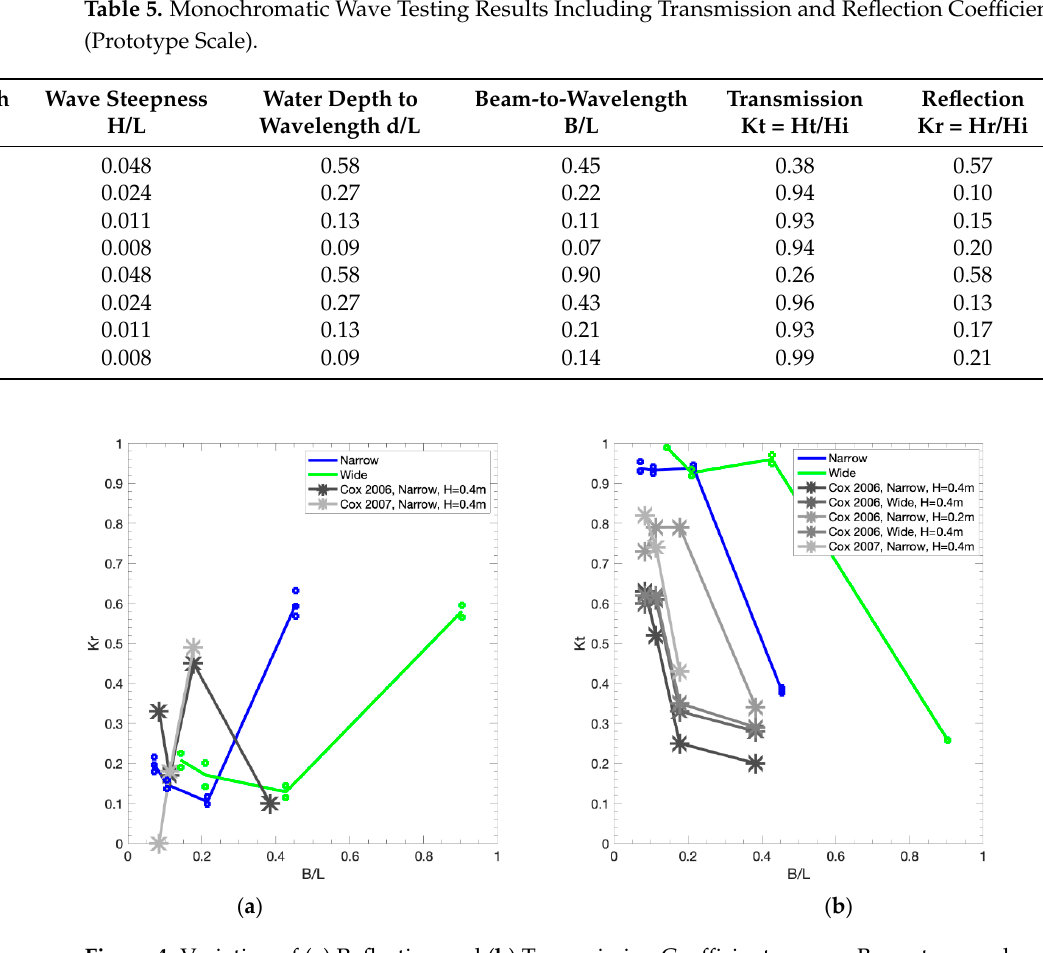
Figure 4. Variation of ( a ) Reflection and ( b ) Transmission Coefficients versus Beam-to-wavelength (B/L) for the Narrow and Wide Pontoon based on monochromatic boat wake (H = 0.3 m) for a draft of 0.455 m. Repeat tests are included as dots with lines representing the average. For comparison, available Kt and Kr values for similar studies [6,7] are included, noting that the draft in [6,7] was 1.7 m and this affects the movement of the